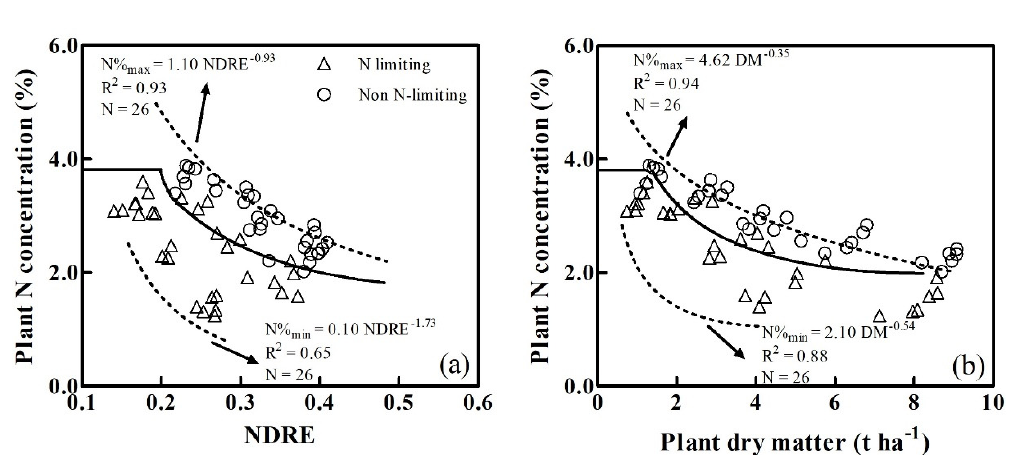
Figure 6. Validation of the critical N dilution curves established by NDRE ( a ) and PDM ( b ). Dashed lines represent the maximum and minimum boundaries of plant N concentrations.